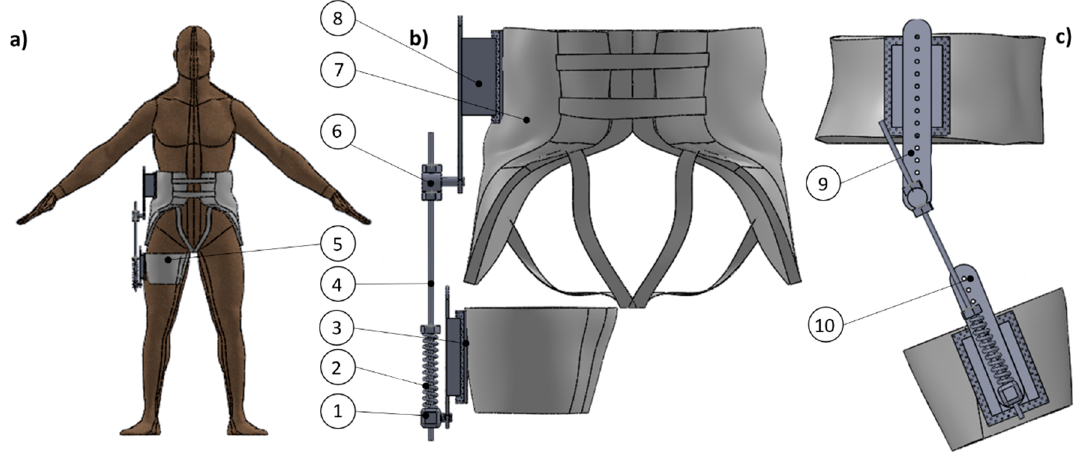
Figure 4. 3D model developed: ( a ) full body view; ( b ) front view; ( c ) lateral view.